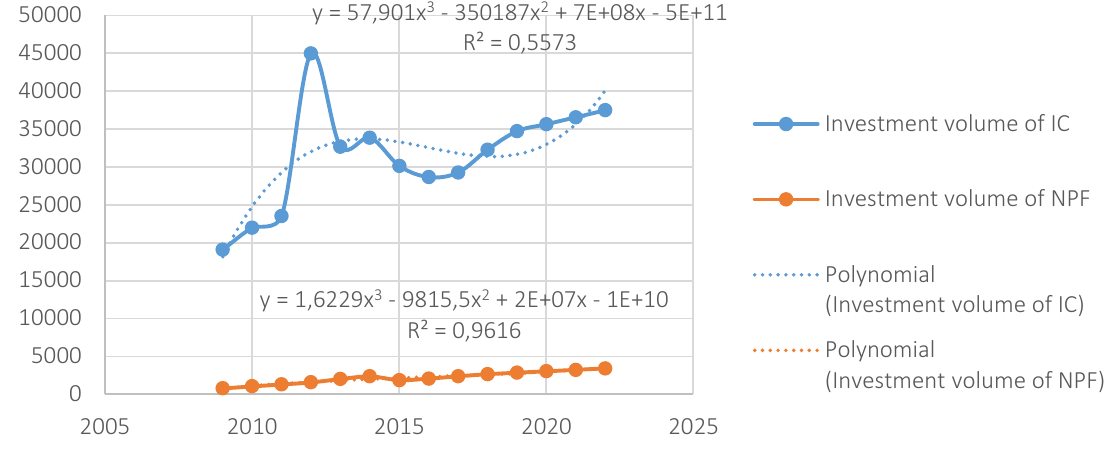
Figure 2. Trend model of investment volume of IC and